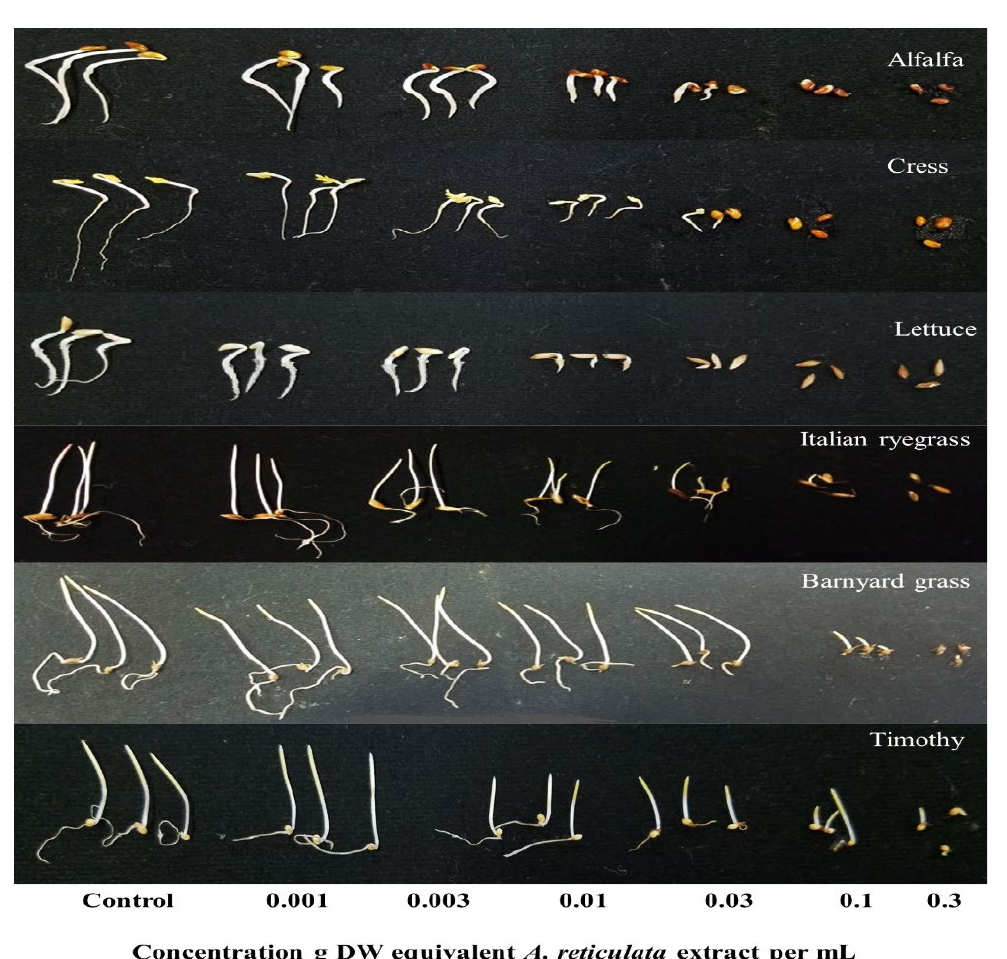
Figure 1. Effect of the A. reticulata leaf extract treatment at six concentrations on the test plant species (alfalfa, cress, lettuce, Italian ryegrass, barnyard grass, and timothy).